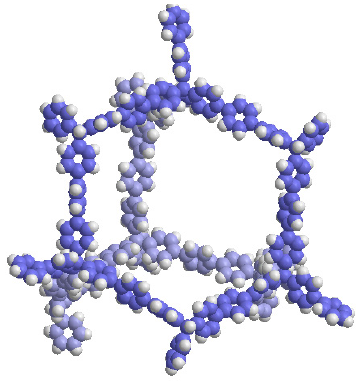
Figure 1. The representative structure of porous aromatic framework with dia topology; three benzene rings in the edge.